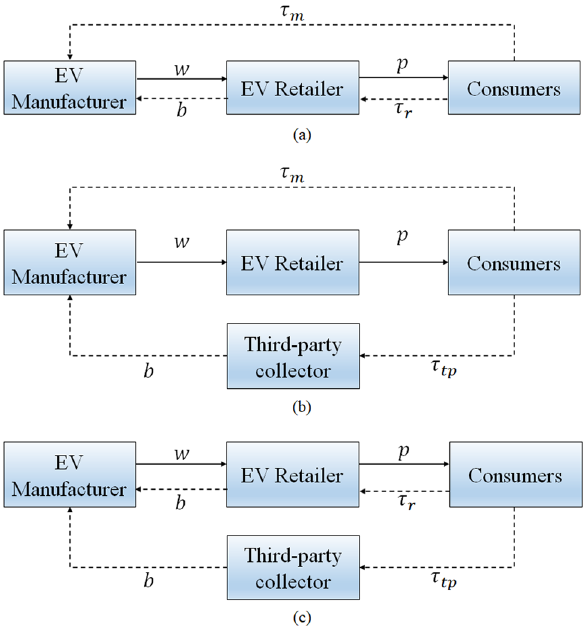
Figure 1. Three dual-channel collection modes: ( a ) the M&R mode; ( b ) the M&TP mode, and ( c ) the R&TP